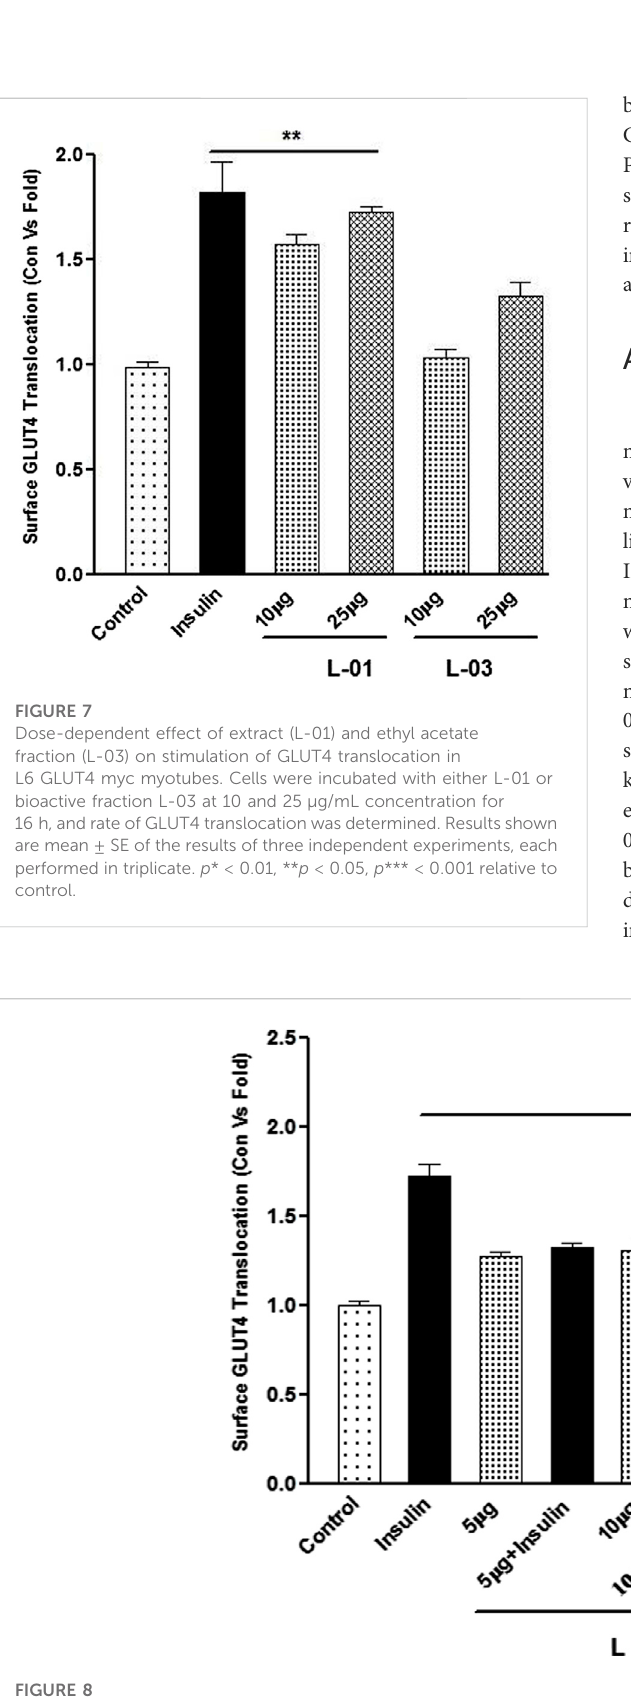
FIGURE 8 Dose-dependenteffectofextractL-01oninsulin-stimulatedGLUT4translocationinL6GLUT4mycmyotubes.CellswereincubatedwithextractL- 01 at 5, 10, and 25 μ g/mL for 16 h, followed by 3 h of serum starvation with a subset of cells stimulated with 100 nM insulin for 20 min, followed by determination of the GLUT4 translocation rate. Results shown are mean ± SE of the results of three independent experiments, each performed in triplicate. p * < 0.01, ** p < 0.05, p *** < 0.001 relative to